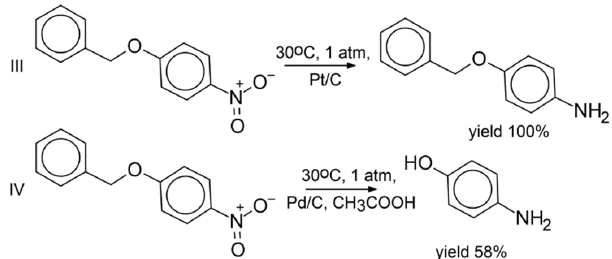
Figure 3. Regioselective reduction of 1 ‐ benzyloxy ‐ 4 ‐ nitrobenzene. Reaction III: predicted condition combination was medium t, low p, platinum on carbon; yield of target product was 100%. Reaction IV: predicted conditions were medium t, low p, palladium on carbon, acid; yield of target product was 58%, 42% was the incomplete reduction product—4 ‐ (benzyloxy)aniline.